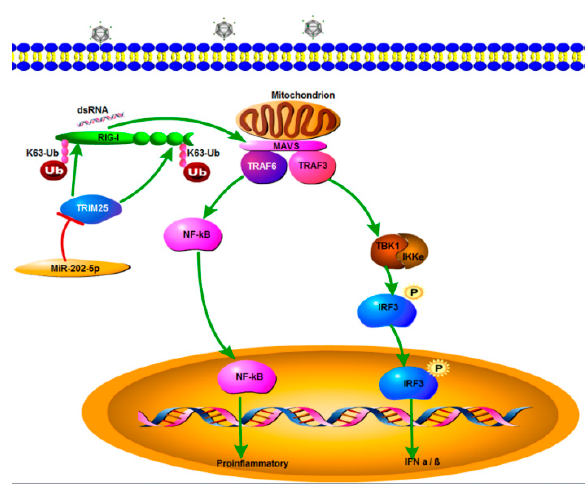
Figure 8. A schematic model of miR-202-5p-mediated RIG-I-like receptors (RLRs) signaling pathway during viral infection. miR-202-5p targets zbTRIM25 and inhibits zbTRIM25-mediated zbRIG-I ubiquitination, thereby negatively regulating RLRs signaling pathway during RGNNV infection.